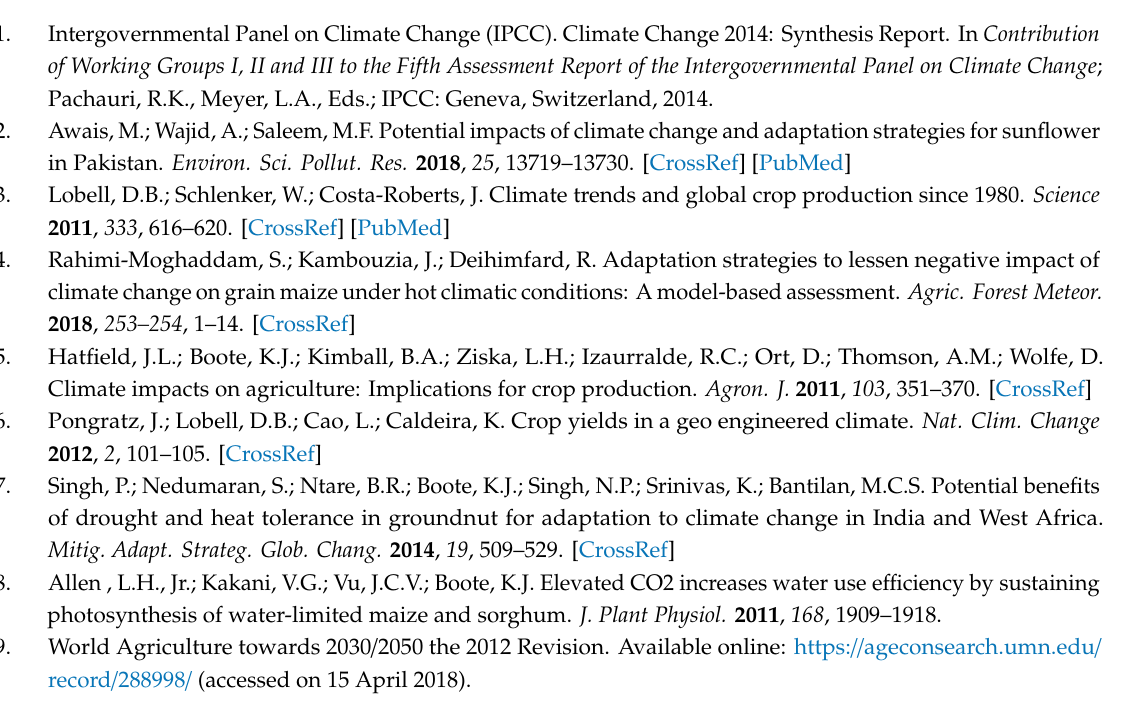
Figure S1: Model performance during calibration for maize grain yield, Figure S2: Evaluation results of yield between observed and simulated at experimental fields, Figure S3: Evaluation results of yield between observed and simulated at farmer fields, Figure S4: Spatial and temporal evolution of the climate parameters during 2021–2080; Seasonal Change in: (a) Precipitation (%) (b)Temperature ( ◦ C), (c) Solar radiation (MJ m − 2 / month), Table S1: Irrigation scheduling based on ET (mm) during 2012, 2013, 2014, and 2015 growing seasons at the experimental fields in Yangling, Table S2: Total irrigation amount (mm) applied during 2012, 2013, 2014, and 2015 growing seasons at the experimental field in Yangling, Table S3 : CERES-Maize model calibrated coe ffi cients of maize crop Wuke-02 (a) for experiments, and Zhong dan-02 (b) for farmer field in 2010, 2011, 2012, 2013 and 2014, Table S4: CERES-Maize model results between simulated and observed data of full irrigation Table 2010. 2011 and